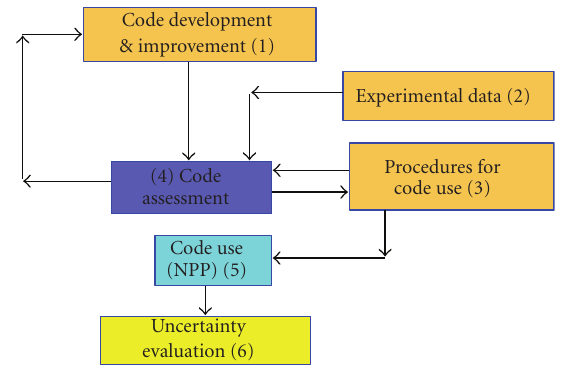
Figure 2: A consistent application (development, qualification and application) of a thermalhydraulic system